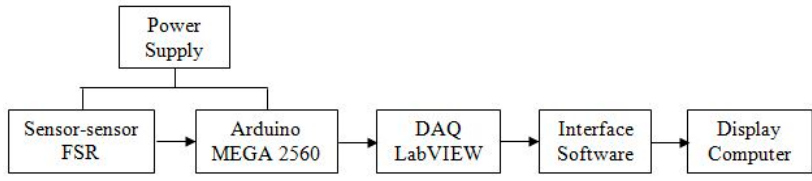
Figure 3. Block diagram system of static load gauge of soles.